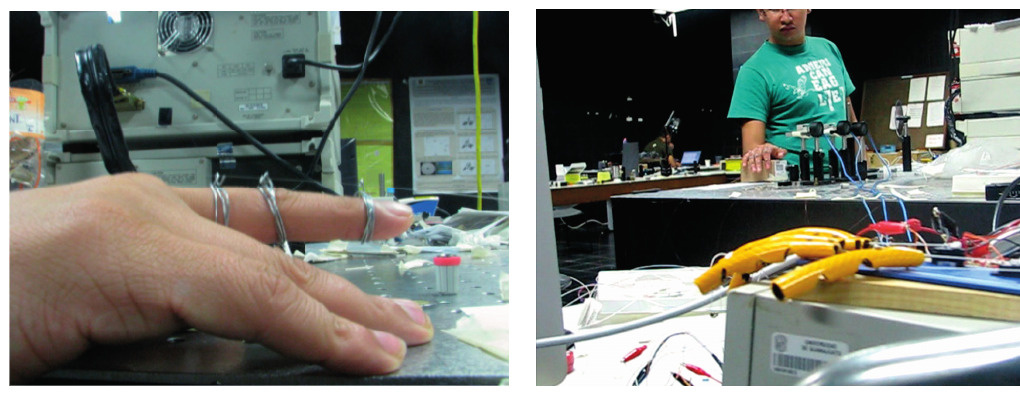
Figure 5. Experimental setup. Left : The LFPG sensor adapted to one finger; Right :